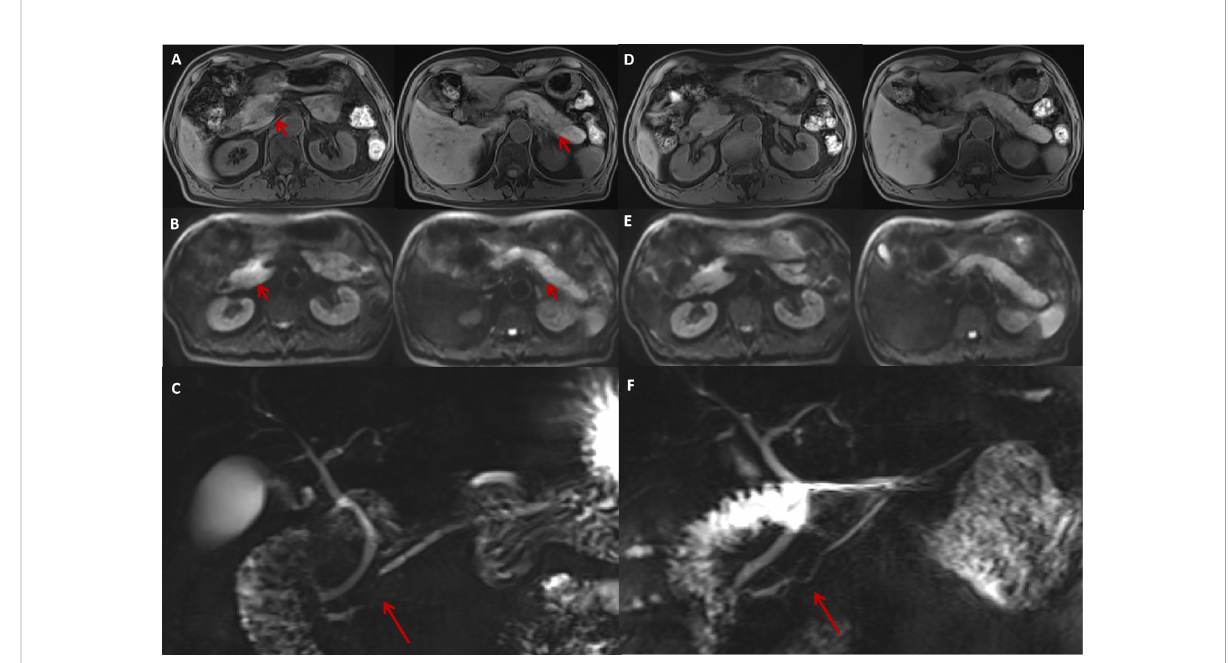
FIGURE 1 The MRI features of irAP and its improvement after treatment. The MRI at diagnosis revealed a slightly swollen pancreas with multiple nodular ( A , arrow) and patchy abnormal signals with decreased intensity on T1WI sequences (A) and increased intensity on DWI ( B , arrow) located in the pancreatic head and tail. MRCP showed segmental stenosis of the MPD in the pancreatic head ( C , arrow). After 1 month of prednisolone treatment, the swelling reduced and the abnormal signals decreased on T1W1 (D) and DWI (E) sequences. The MPD stenosis also resolved ( F , arrow). irAP, immune-related acute pancreatitis; MRI, magnetic resonance imaging; T1W1, T1-weighted image; DWI, diffusion-weighted imaging; MPD, main pancreatic duct; MRCP, magnetic resonance